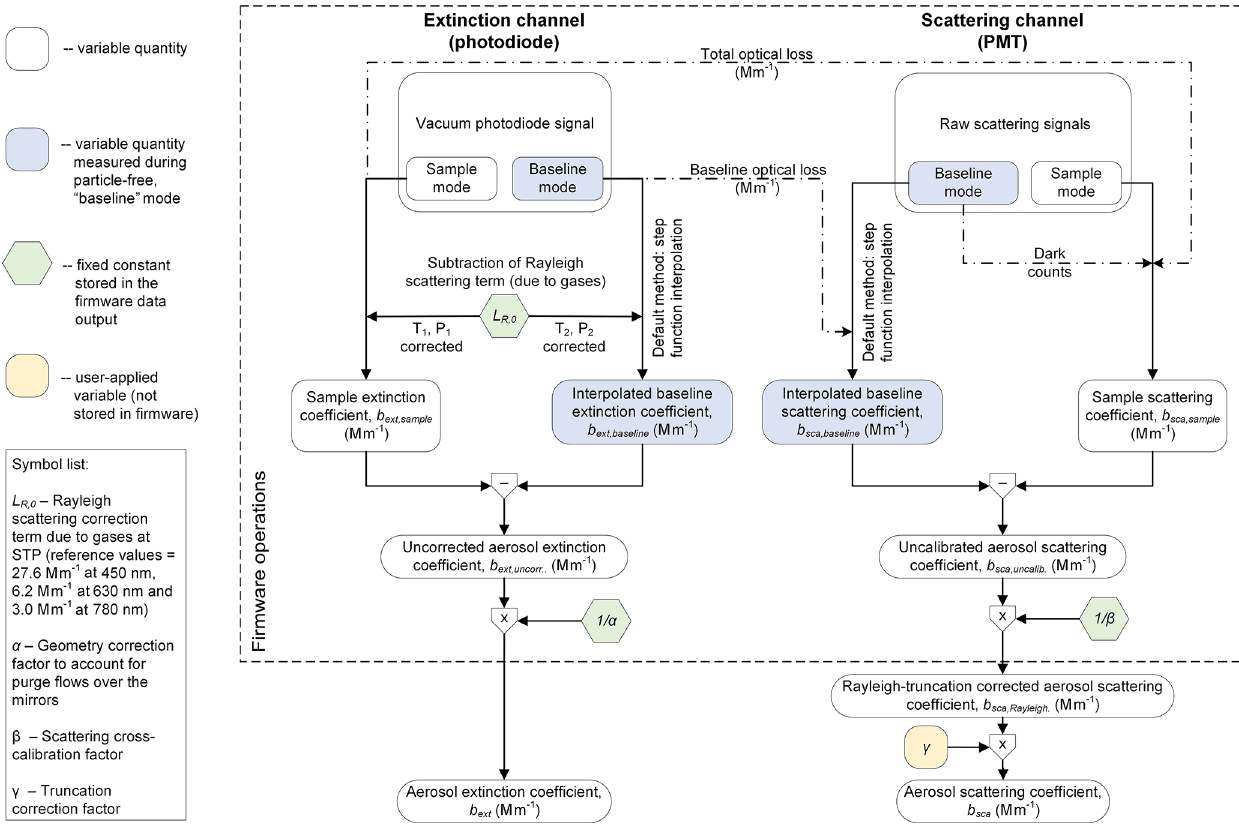
Figure 2. Data processing chain for the extinction and scattering channels of the CAPS PMssa. Blue boxes indicate quantities that are measured during the periodic “baseline” mode of operation of the instrument. Hexagonal containers indicate fixed constants, and rounded rectangular containers represent variable